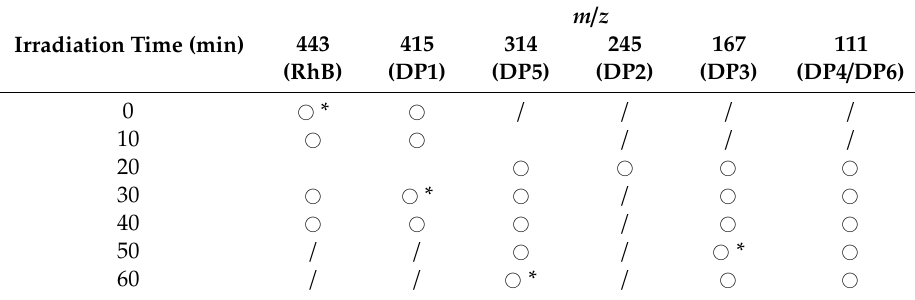
Table 2. RhB and intermediates identified by LC-MS / MS.